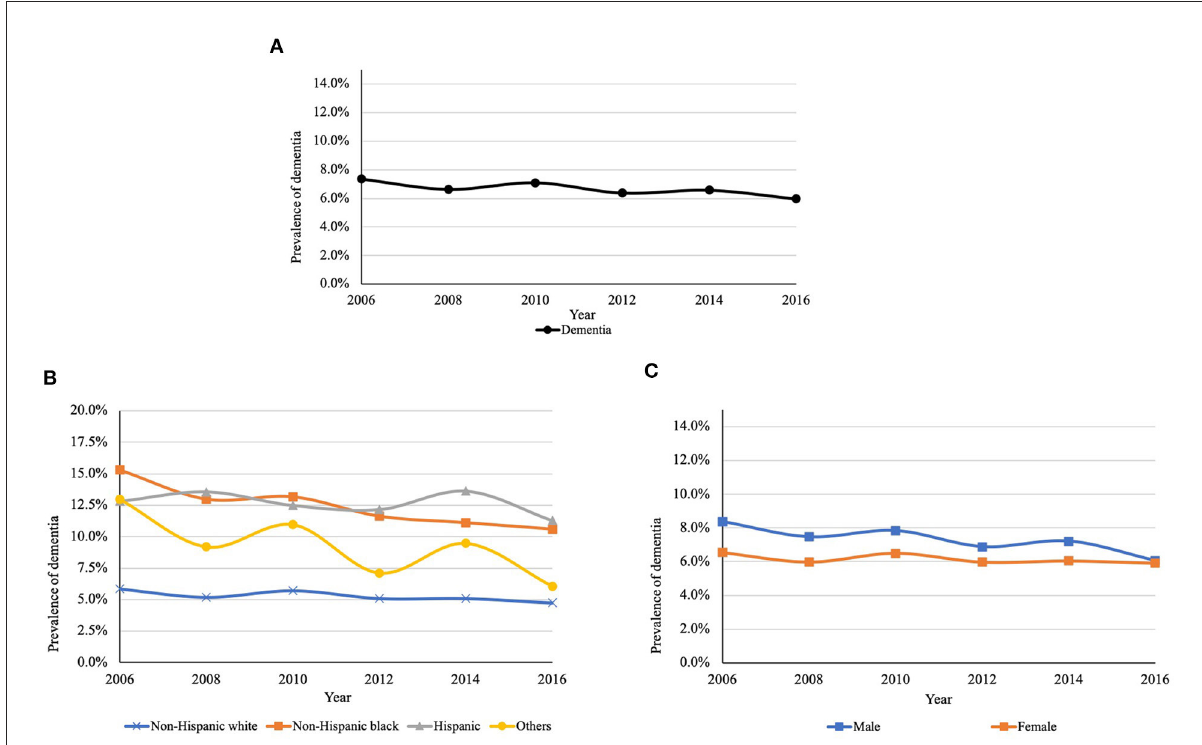
FIGURE3 (A) Trends in the prevalence of dementia between 2006 and 2016. (B) Trends in the prevalence of dementia between 2006 and 2016 by race/ethnicity a . (C) Trends in the prevalence of dementia between 2006 and 2016 by gender b . a P < 0.001; b P < 0.001. P -values are for the type 3 test for the difference in the prevalence among race and